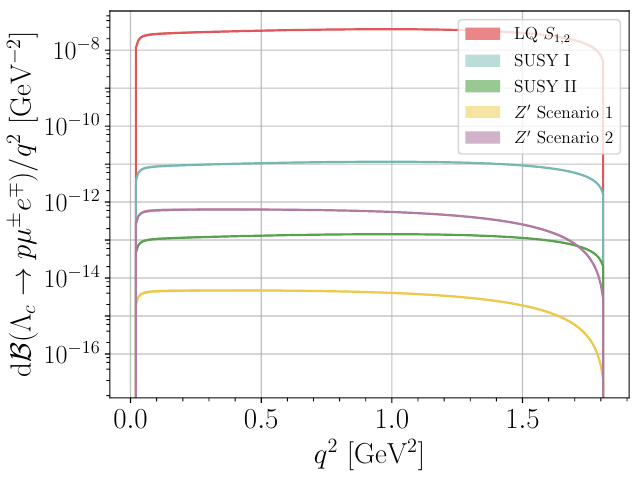
Figure 8 . The differential branching fraction for Λ c → pµ ± e ∓ with lepton flavor violating NP contributions in a LQ scenario ( K 0 = K 0 = 0 . 5 ), SUSY scenarios with and without R-parity 9 10 violation ( K = − K = 0 . 009 and K = − K = 0 . 001 ) and two different Z 0 scenarios ( K 9 10 9 10 = − K = − K 0 = 1 . 4 · 10 − 4 and K = K 0 = − K = − K 0 = 2 . 3 · 10 − 4 ). The BSM K 0 10 9 10 9 10 9 10 benchmarks are adapted from ref. [8]. The error bands include form factor